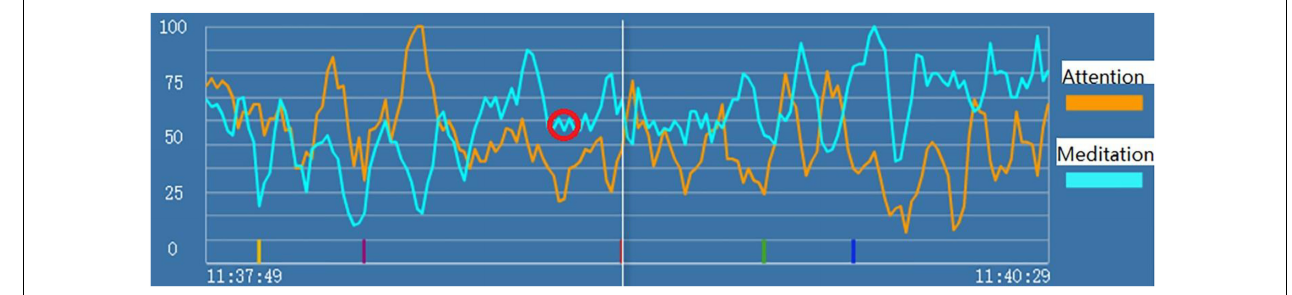
FIGURE 1 | “Attention” (the orange line) and “meditation” (the blue line) signals during psychological counseling intervention for depression of Subject A1. The red circle indicates the markers of state